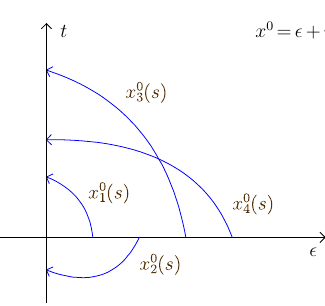
Figure 1 . Inequalities (4.12) should be satisfied along the analytic continuation